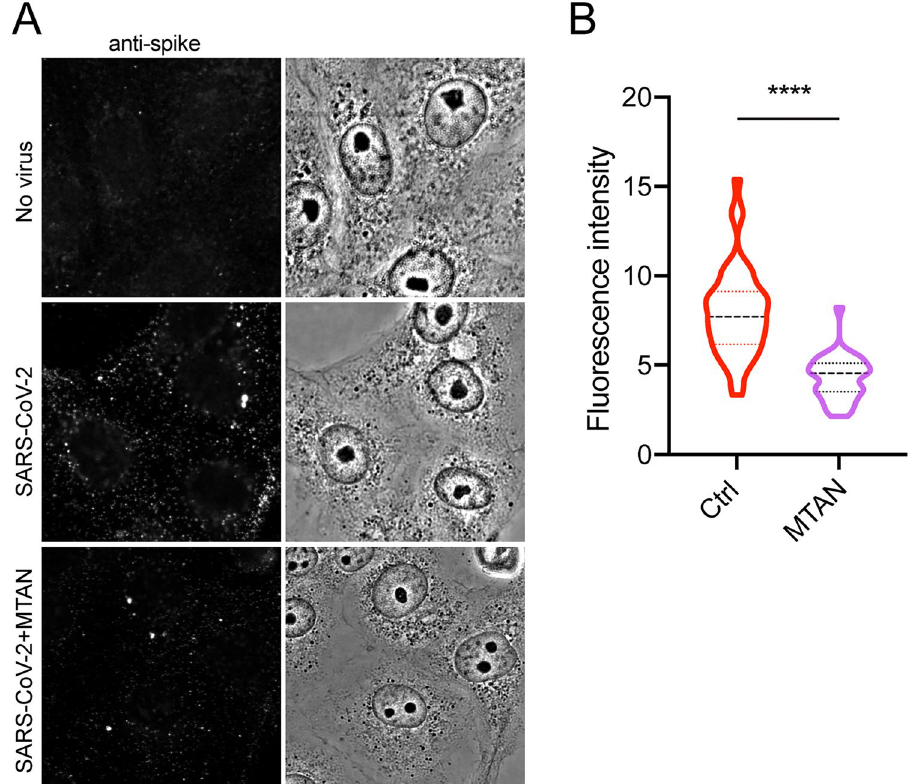
Figure 4. Mitoxantrone inhibits the entry of SARS-CoV-2 into a lung epithelial cell line. (A) Cells grown in monolayer were treated with Mitoxantrone (200 nM) and then infected with SARS-CoV-2 (USA-WA1/2020) at an MOI of 0.1. Five hours later, cells were fixed and stained with rabbit anti-spike antibodies in combination with goat anti-rabbit IgG conjugated with Alexa Fluor 488 (left panels). (B) Quantification of spike fluorescence intensity in (A) . ****, p < 0.0001 by unpaired student’s t-test, n = 3 independent